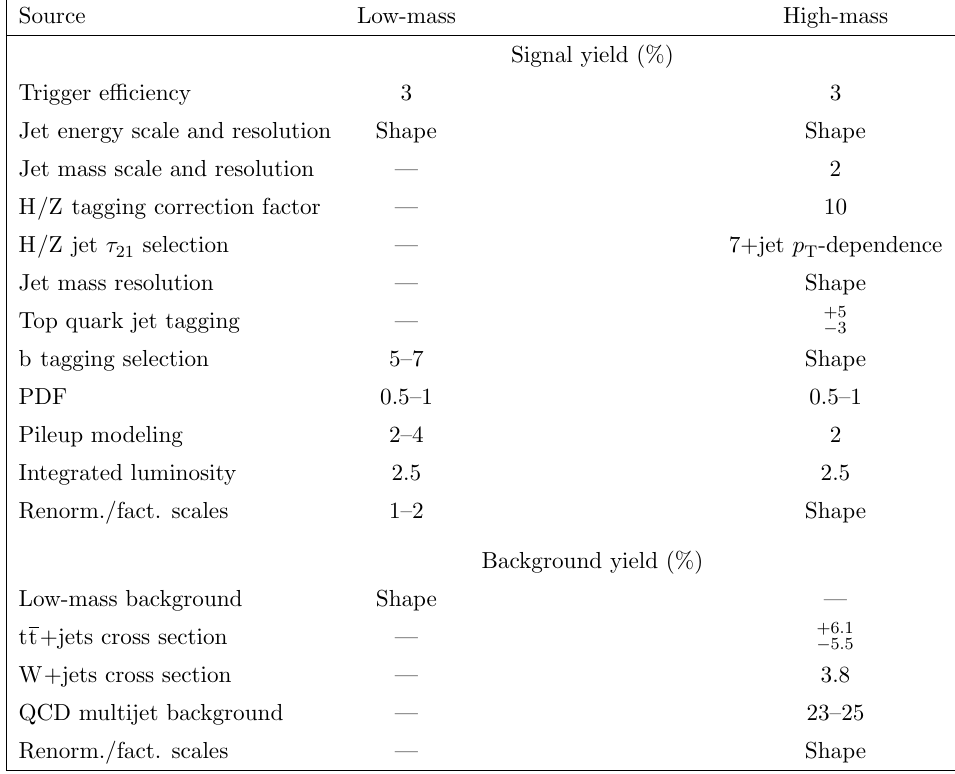
| Shape Table 6 . The systematic uncertainties in the signal and background yields for each search. The uncertainties marked \Shape" a(cid:11)ect both the event yields and the